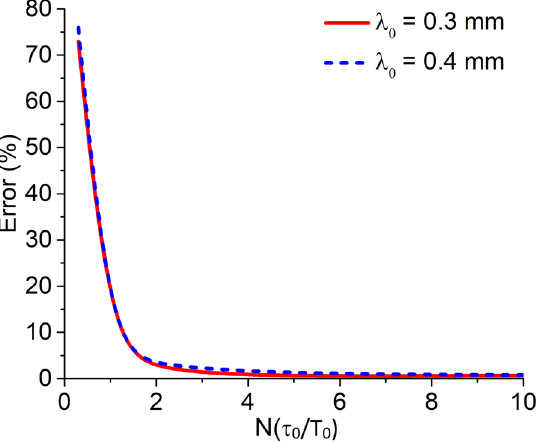
Figure 2. Dependence of n 2 measurement error on the number of THz pulse periods for a fixed thickness of the sample L = 0.3 mm and pulse wavelengths λ 0 = 0.3 mm and 0.4 mm.